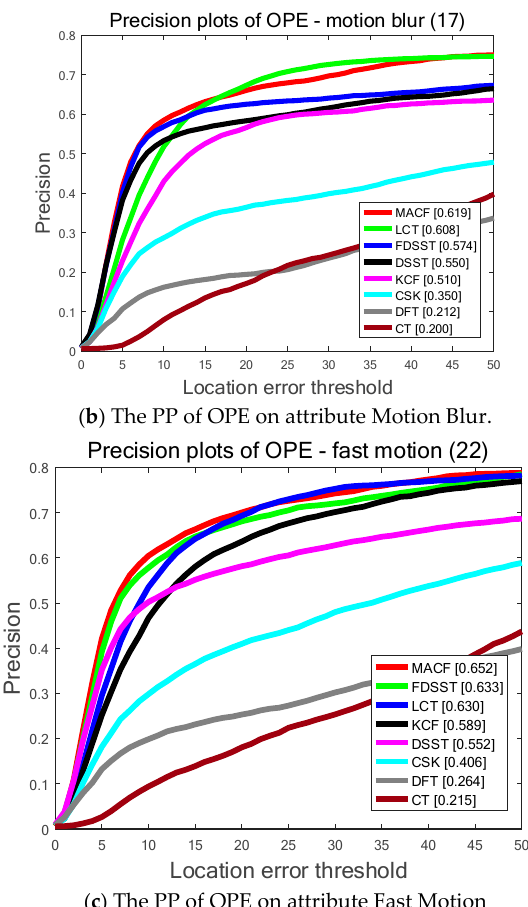
Figure 5. The Precision Plots (PP) of One Pass Evaluation (OPE) on OTB-50 benchmark for the top eight trackers determined by 3 different attributes: occlusion, motion blur and fast motion. Among the top eight trackers our MACF obtains the best results on all 3 attributes.